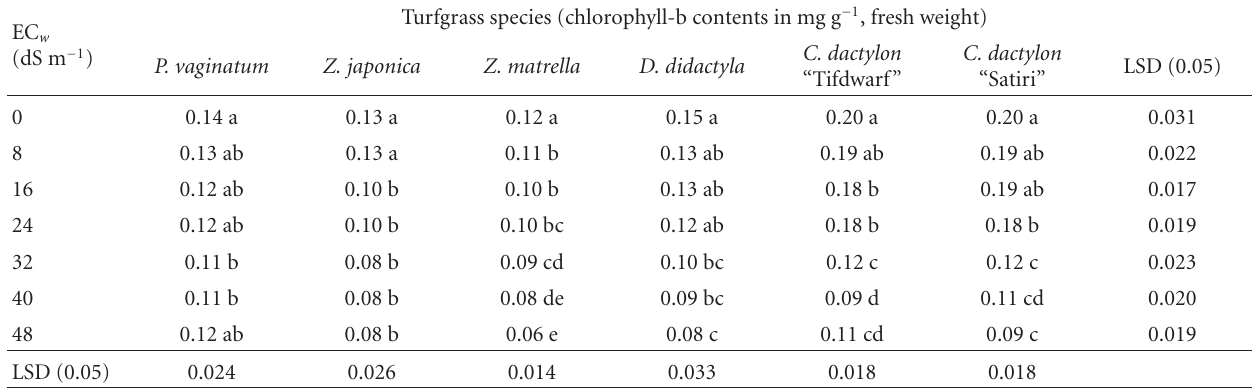
Table 7: E ff ect of salinity on chlorophyll-b concentration of six turfgrass species.